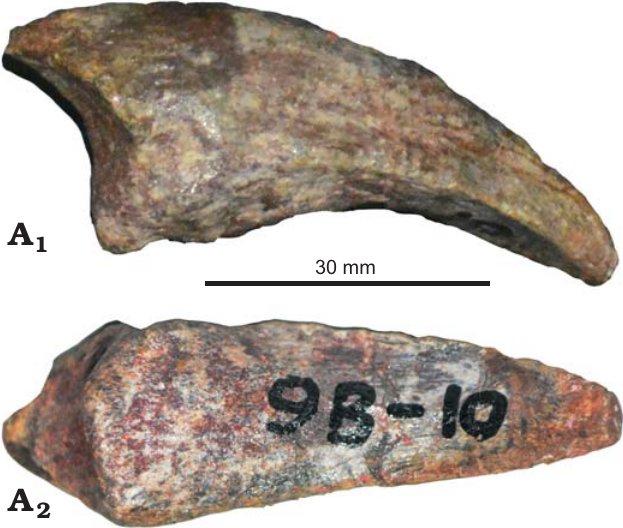
Fig. 14. Coelurosaurian theropod Phuwiangvenator yaemniyomi gen. et sp. nov. from the Early Cretaceous Sao Khua Formation of Phu Wiang, Khon Kaen Province, Thailand. SM-PW9B-10, right pedal ungual IV-5 in lateral (A 1 ) and ventral (A 2 )